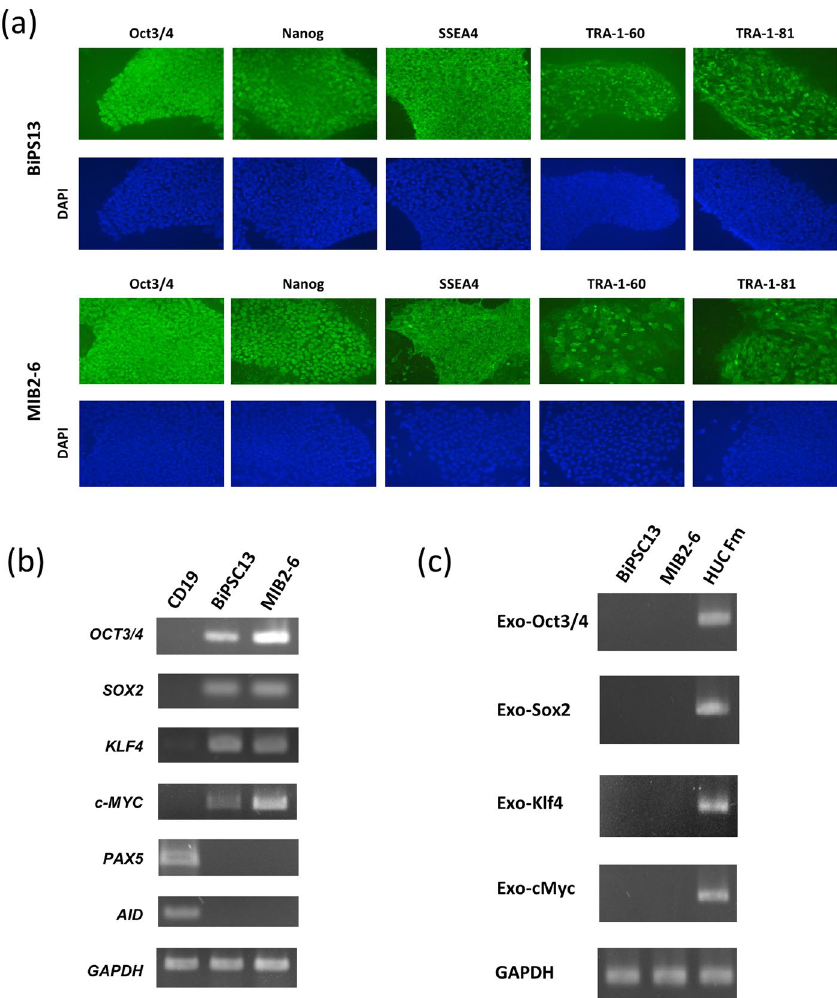
Figure 3. Characterization of the BiPSCs. ( a ) Immunofluorescence staining of BiPSC13 and MIB2-6 for expression of the pluripotent markers Oct3/4, Nanog, SSEA4, TRA-1-60, and TRA-1-81. ( b ) Expression of endogenous Oct3/4, Sox2, Klf4, cMyc, Pax5, AID , and GAPDH in BiPSCs (BiPSC13, MIB2-6) and normal B cells (CD19) from the lymph node analyzed using RT-PCR. ( c ) RT-PCR analysis of the expression of retrovirus- derived Oct3/4, Sox2, Klf4 , and cMyc in BiPSCs (BiPSC13, MIB2-6). HUC-Fm, human umbilical cord fibroblast cells, (male; RIKEN, Tsukuba, Japan) infected with a retrovirus containing Oct3/4 , Sox2 , Klf4 , c-Myc , and GAPDH for 5 days were used as the positive